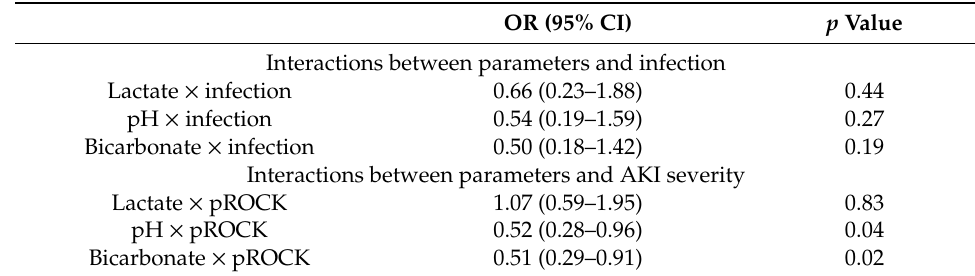
Table 3. Interactions of 28-day mortality in children with acute kidney injury by logistic